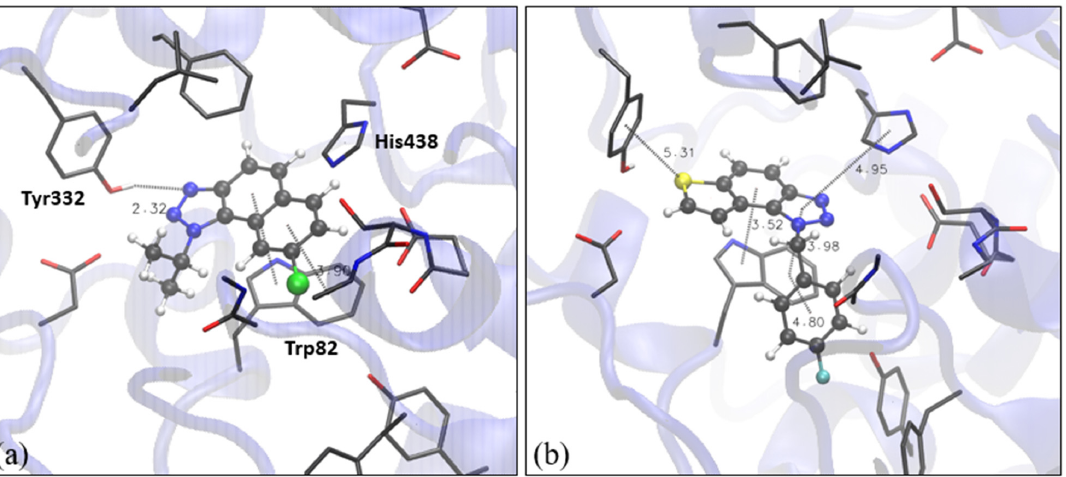
Figure 5. Structure of the active site of BChE docked with naphtho-triazole 1 ( a ) and thienobenzo- triazole 4 ( b ). Molecules of the potential inhibitors are presented using a ball-and-stick model. Finally, the most promising candidate for inhibition of BChE is compound 9 , with an excellent experimental value of IC 50 (Table 1). The structure of the BChE active site docked with 9 , shown in Figure 6, reveals that there are two possible H-bonds: one is formed between the triazole nitrogen and hydroxyl of the Tyr128 (analogously to the occurrence of hydrogen bond between triazole nitrogen and Tyr121 in AChE), and the other is possible due to the proximity of the oxygen of the ligand’s methoxy group and proton of the -OH group of the Tyr332. π - π stacking between the triazole ring of the ligand and the residue Trp82 is present, as well as π -alkyl interaction between the ethyl (that connects triazole and methoxy phenyl) and His438.